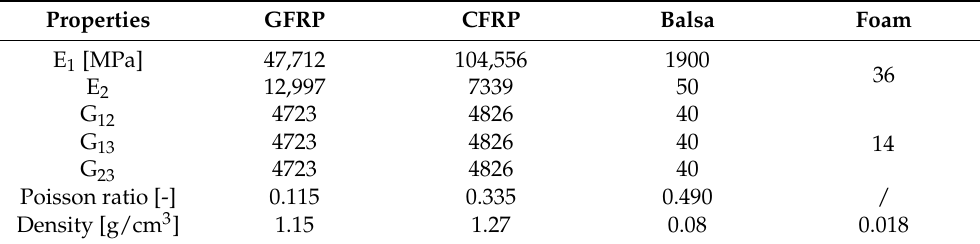
Figure 4. Finite elements Half-wing model. ( a ) Half wing FE model, ( b ) Half-wing FE model with associated properties: Balsa (green) for ribs and spars, Foam + CFRP (red) for the tubular spars,